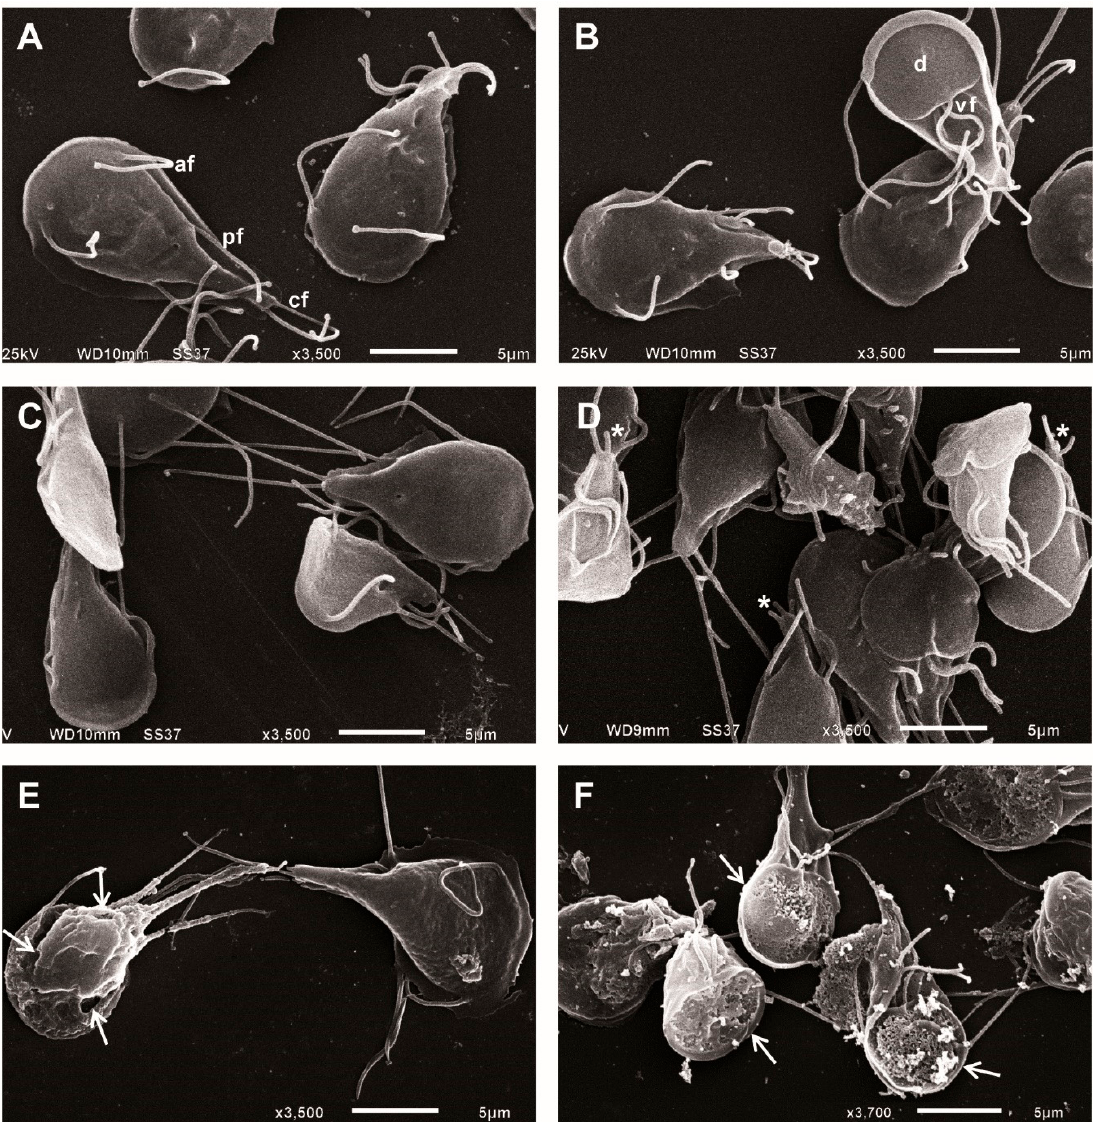
Figure 2. SEM micrographs of Giardia lamblia trophozoites after 48 h of treatment with ASA. Untreated cells ( A ), DMSO ( B ), 0.125 mM ( C ), 0.25 mM ( D ), 0.5 mM ( E ) and 1 mM ( F ). (d = ventral disk; af = anterior flagella, vf = ventral flagella, pf = posterior-lateral flagella and cf = caudal flagella). Bar = 5 and 10 µ m. Asterisks point flagella shortening and arrows indicate perforations.